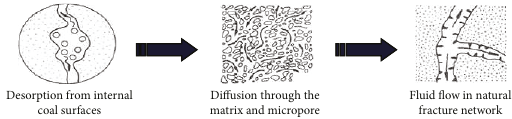
Figure 1: Gas transport mechanisms in the reservoir